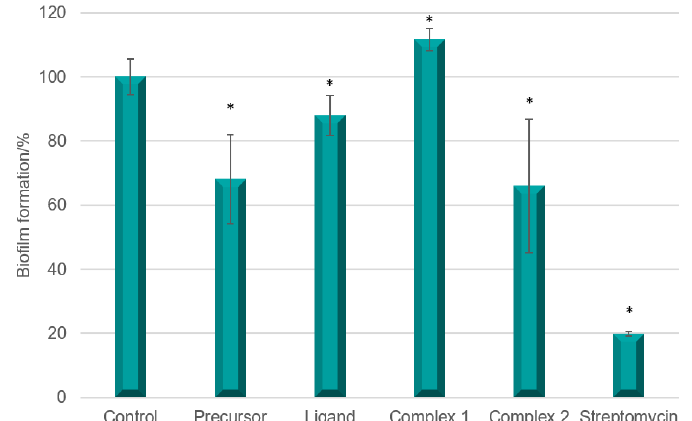
Figure 6. P. aeruginosa PAO1 biofilm formation in the presence of Ru(II) precursor, free bimCOOH and arene Ru complexes (concentration of compounds—1 mM). The absorbance of the control was considered to represent 100% of biofilm formation (results were considered significant when compared to control; * p < 0.05. Data are presented as mean ± SD, n = 4).